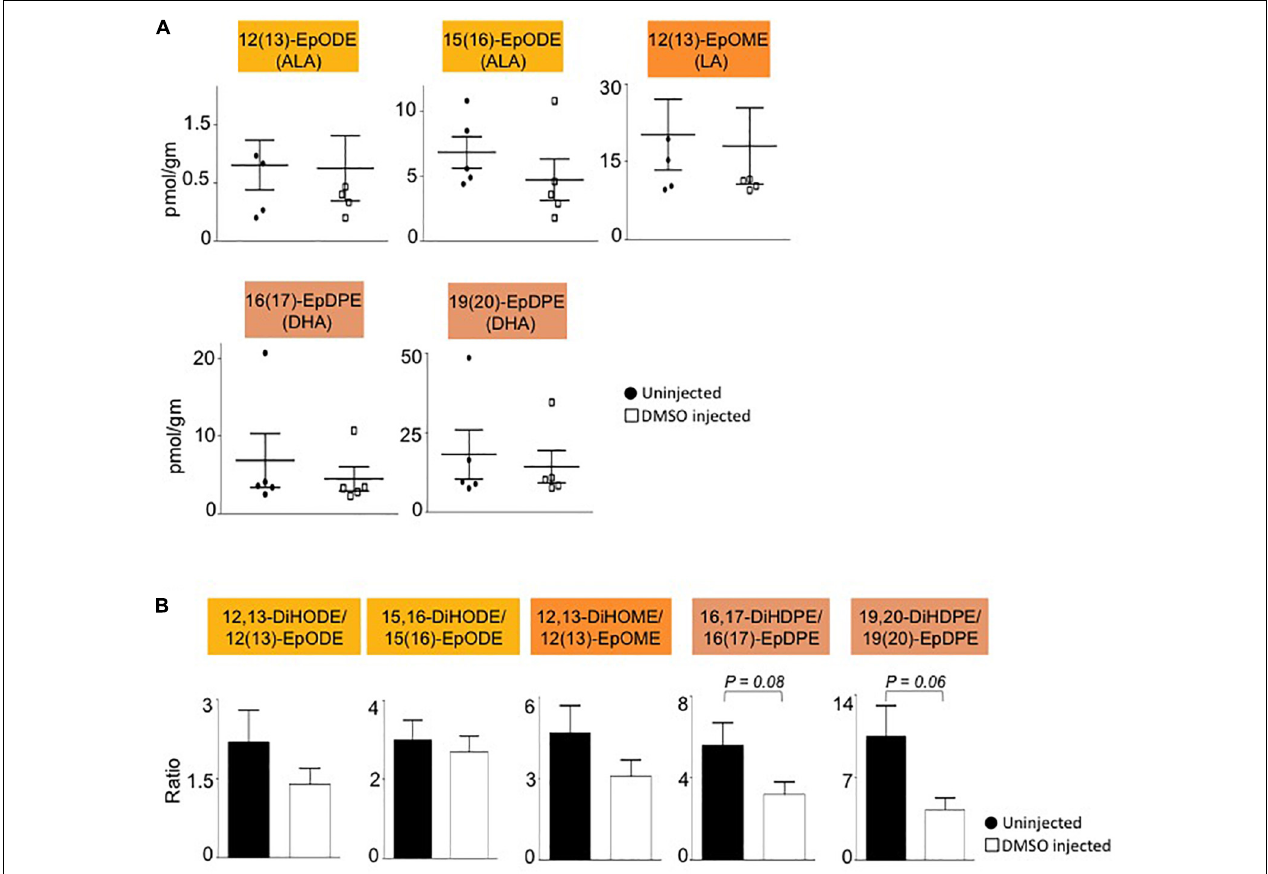
FIGURE 4 | Liver epoxide levels and diol:epoxide ratios are not affected by DMSO. (A) Absolute levels of parent epoxides of diols (shown in Figure 3 ) in liver of mice injected with 1% DMSO ( (cid:3) ) compared to uninjected controls ( ). The fatty acid from which the oxylipin was derived is shown in parentheses. (B) Ratio of diol:epoxide as a measure of soluble epoxide hydrolase (sEH) activity. Color coding for parental fatty acid is same as in panel (A) and Figure 3 . N = 5 mice per (cid:32) group. Data are presented as ± SEM. Significance is defined as P ≤ 0.05.